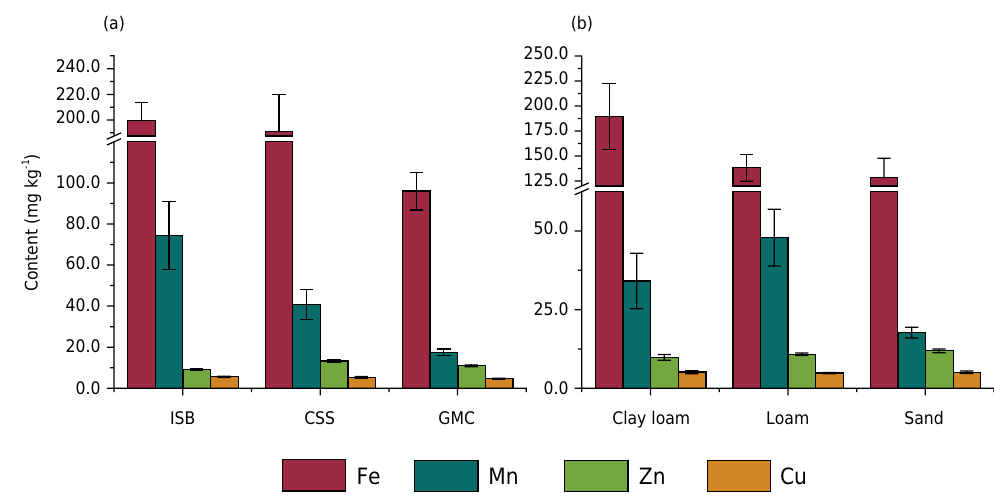
Figure 4. Micronutrient contents in sugarcane (+3 leaves) grown on different pedogeological contexts (a) and soil textural classes (b). ISB: igneous-sedimentary basin; CSS: clay-sandy sediments; GMC: gneissic-migmatite